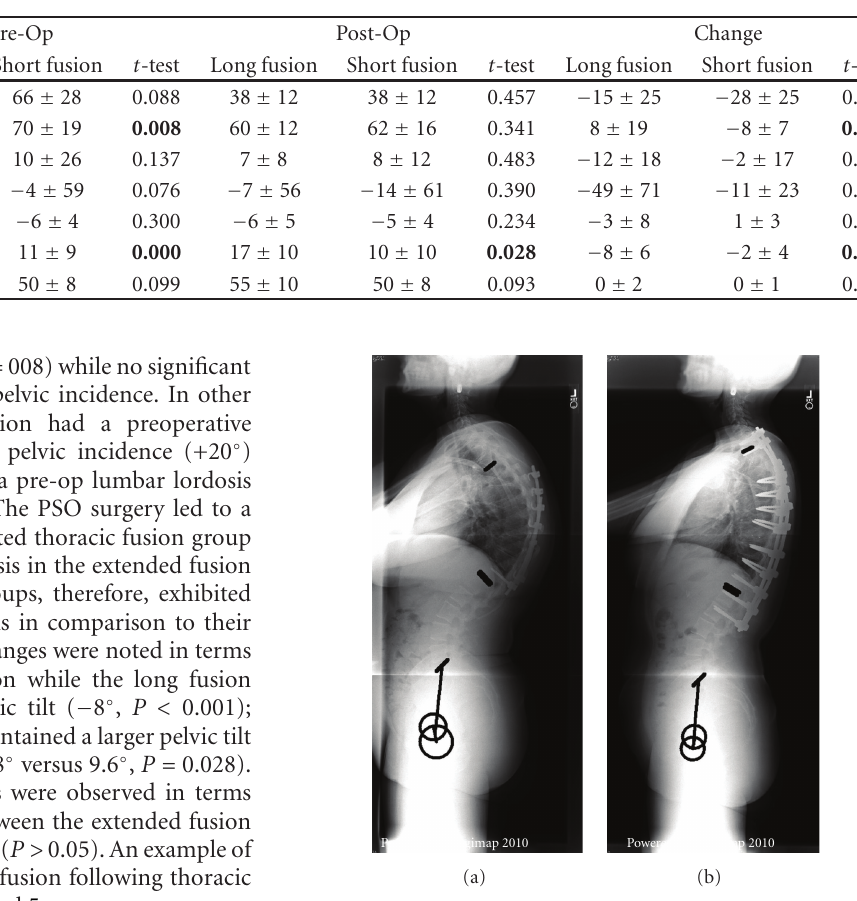
Figure 4: Thoracic resection, limited fusion.